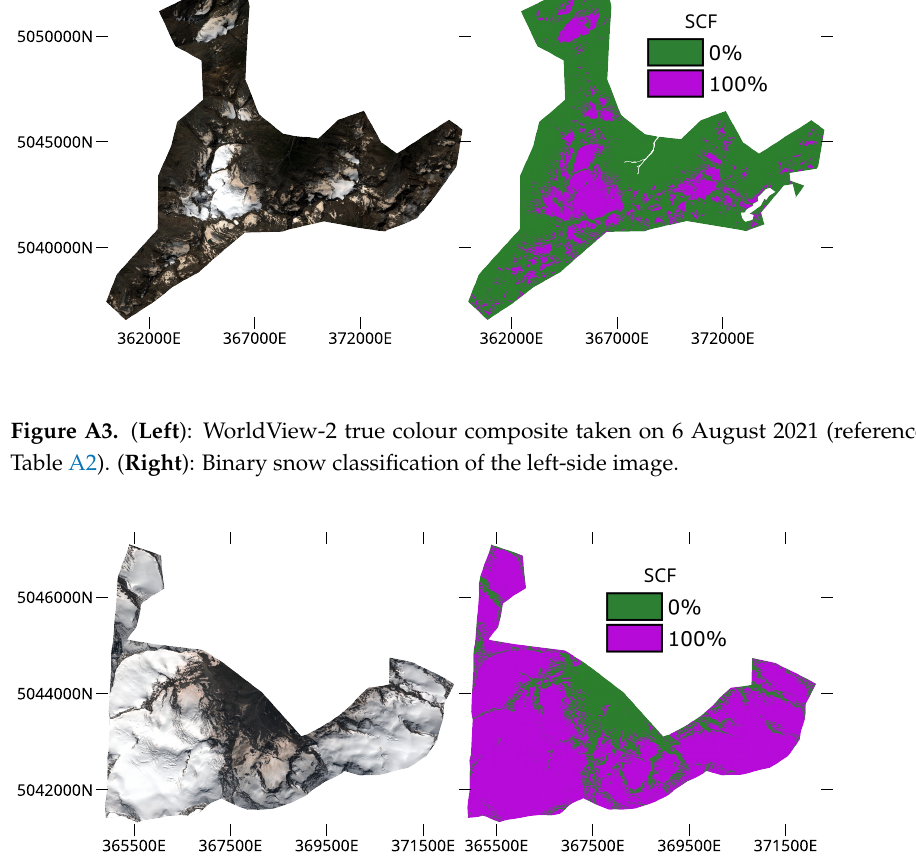
Figure A4. ( Left ): WorldView-3 true colour composite taken on 23 June 2020 (reference № 4 in Table A2). ( Right ): Binary snow classification of the left-side